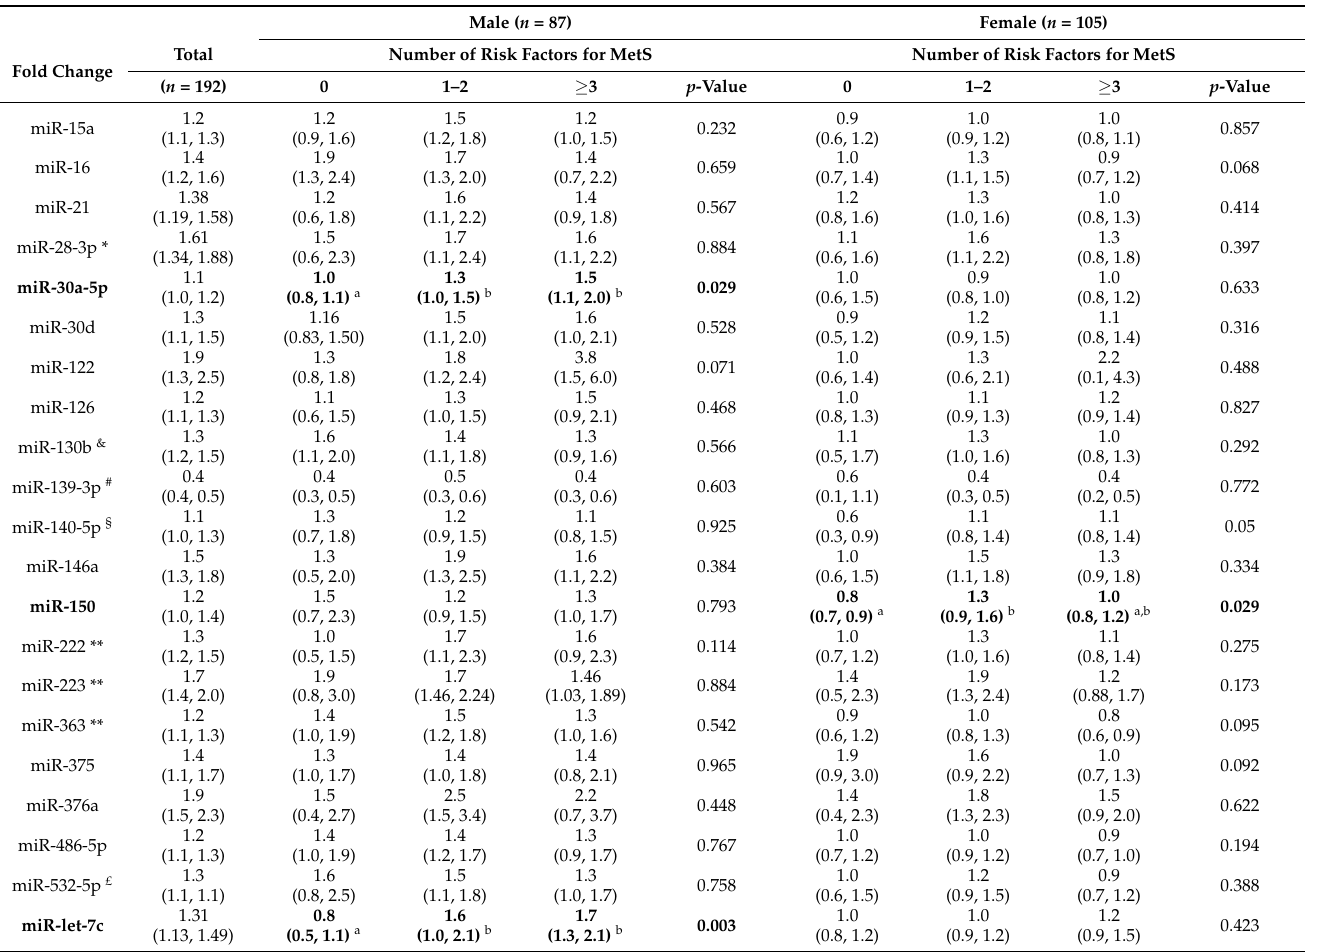
Table 2. Men in the groups with 1–2 and ≥ 3 risk factors had higher levels of miR-let-7c and miR-30a than those in the group without risk factors ( p = 0.003 and p = 0.029, respectively). In women, miR-150 levels were higher in the group with 1–2 risk factors in comparison with the group without risk factors ( p = 0.029). Table 2. Levels of 21 miRNAs in plasma for all study participants from a population-based study and for males and females separately grouped by number of metabolic syndrome (MetS) components. Male ( n =